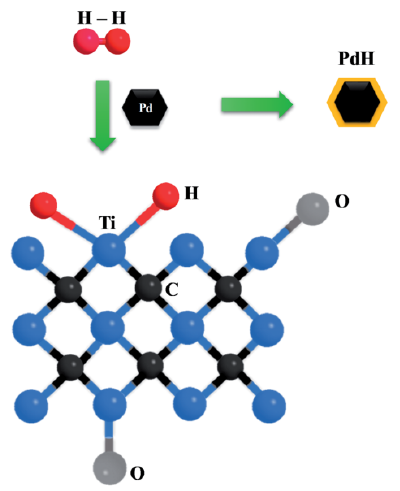
Figure 16. Schematic illustration of H 2 sensing mechanism of the Pd-decorated Ti 3 C 2 T x . Republished with permission from [91]. Royal Society of Chemistry, Creative Commons Attribution 3.0 Unported License.